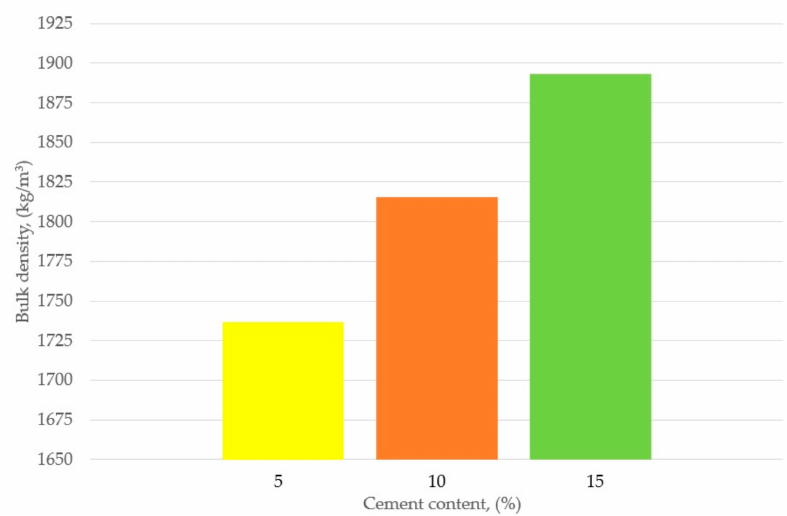
Figure 2. Summary of bulk density